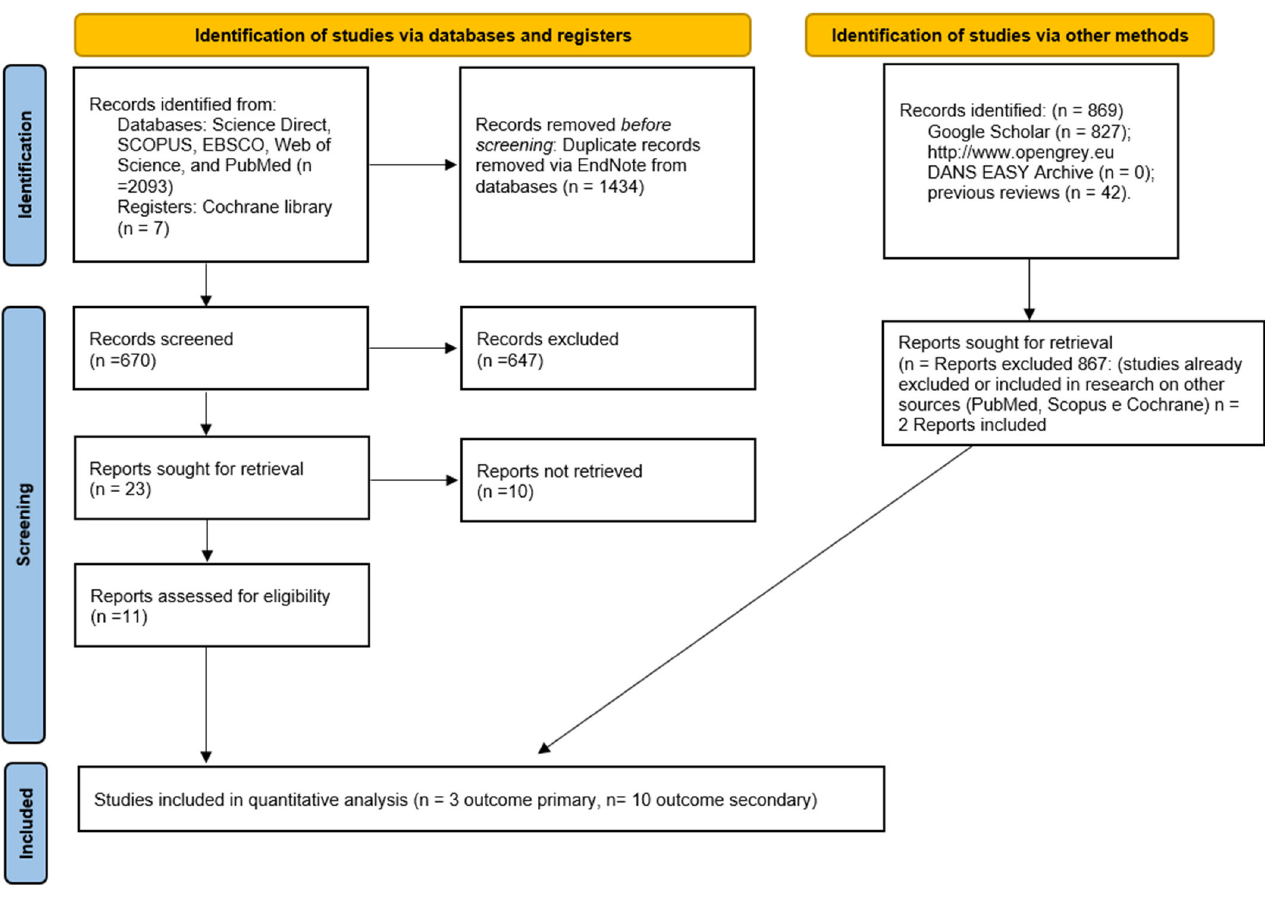
Figure 1. Entire selection and screening procedures are described in the PRISMA flowchart.